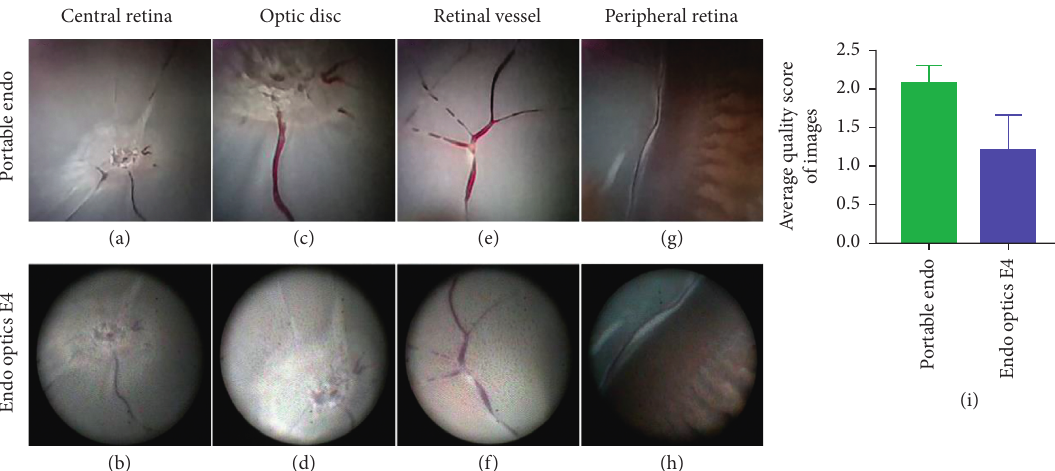
Figure 3: Images of retina captured by the portable endoscope and endo optics E4. An endoscopic image of the central retina with the portable endoscope (a) and E4 (b). The optic disc captured with the portable endoscope (c) and E4 (d). The retina vessels can be visualized by the portable endoscope (e) and E4 (f). The image of the ciliary body and peripheral retina captured by the portable endoscope (g) and E4 (h). The average quality score of fundus images from portable endoscope and E4 were qualified and analyzed (i) P � 0 .